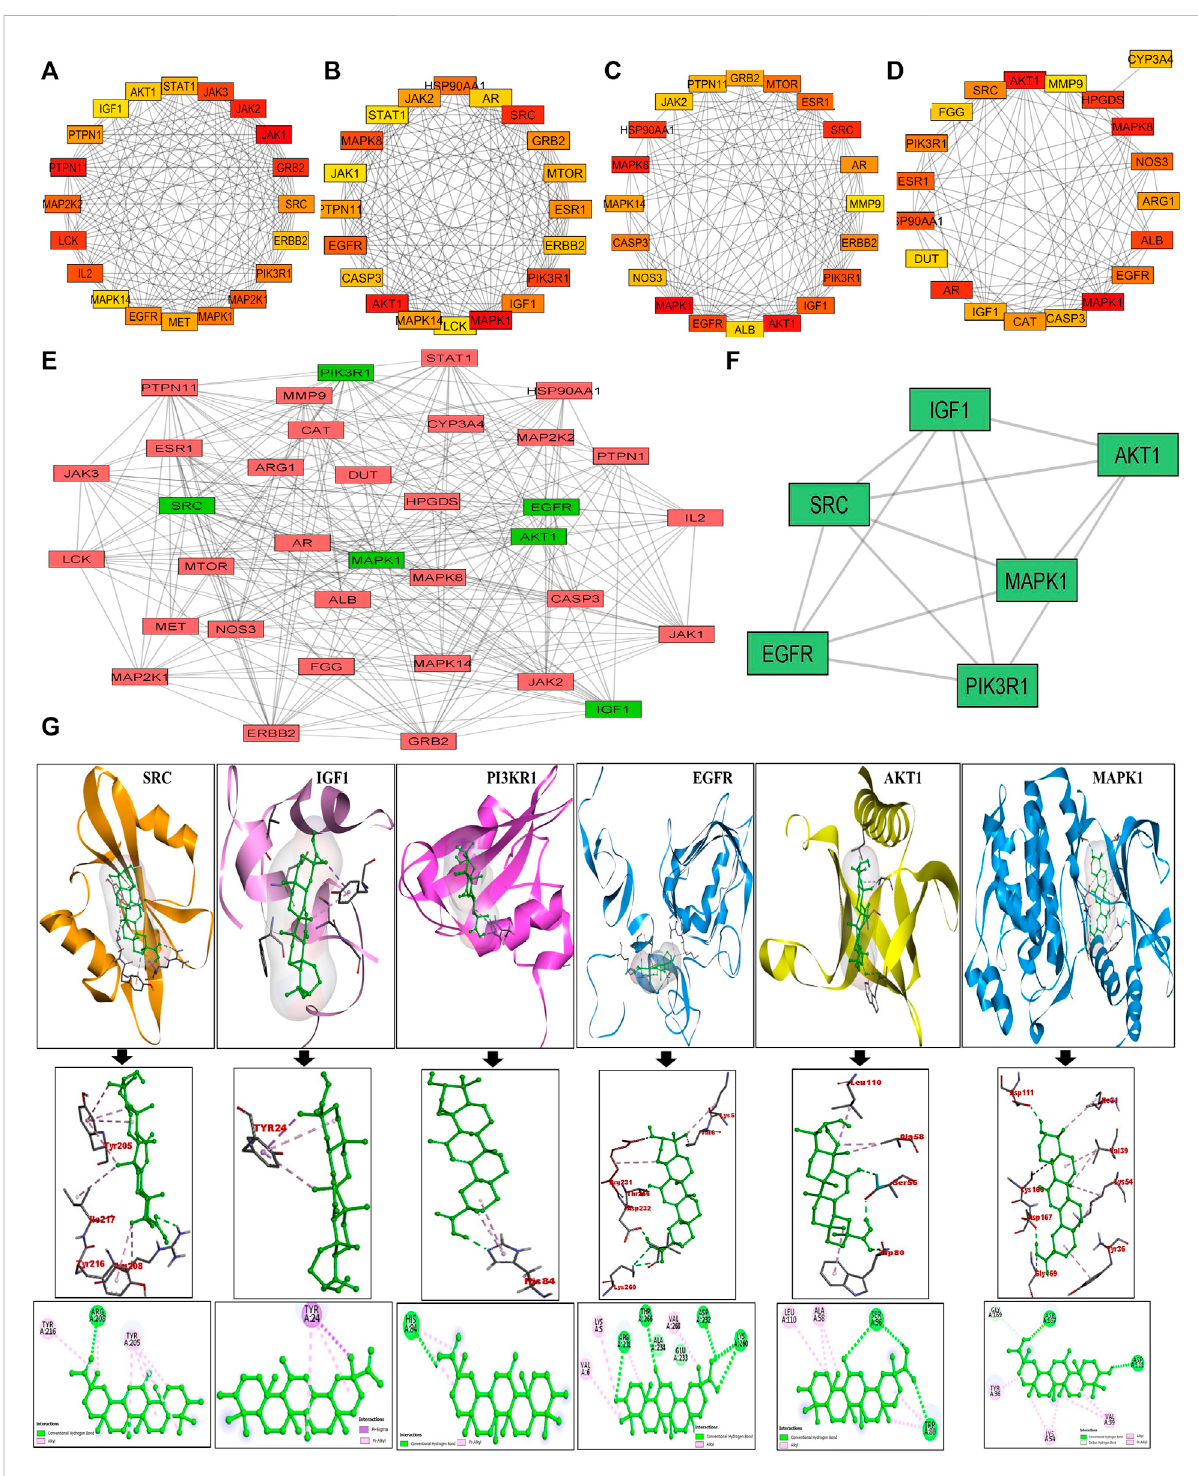
FIGURE 2 Identi fi cation of Top 6 hub/core targets of 18- α GA against NSCLC. (A) Top 20 targets based on MCC visualized by CytoHubba plugin. (B) Top 20 targets based on Degree as visualized by CytoHubba plugin. (C) Top 20 targets based on Betweenness as visualized by the CytoHubba plugin (D) Top 20 targets based on Closeness as visualized by the CytoHubba plugin. (E) The PPI network of identi fi ed hub/core targets of 18- α GA against NSCLCconstructedbymergingtop20targetsobtainedfromCytoHubbapluginvisualizedbyCytoscapev3.8.2;greenrectanglesrepresentthe highly enriched target nodes and pink boxes show less enriched nodes. (F) Top 6 hub nodes interactive PPI network visualized and constructed by Cytoscape v3.8.2. (G) Molecular dockingveri fi cationofthecrucialhubtargets of18- α GAagainstNSCLC.The three-dimensionalstructureof18- α GA docked against the structure of the targets is shown along with the interaction diagram. The arrow represents the docking complexes in 3D and 2D poses